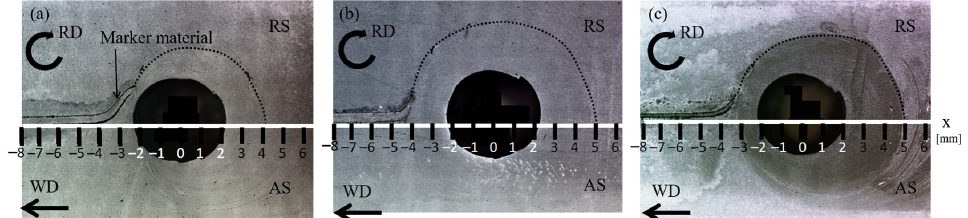
Figure 2. Optical micrographs of horizontal sections of FSW joints for pure Al at ( a ) 0.56 T m and ( b ) 0.67 T m ; ( c ) high-purity Al at 0.50 T m .